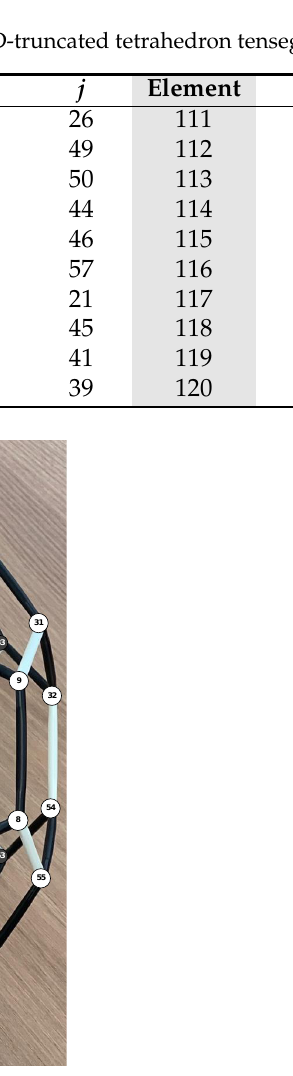
Figure 18. The nodal points of the 3D-truncated tetrahedron tensegrity are numbered on the